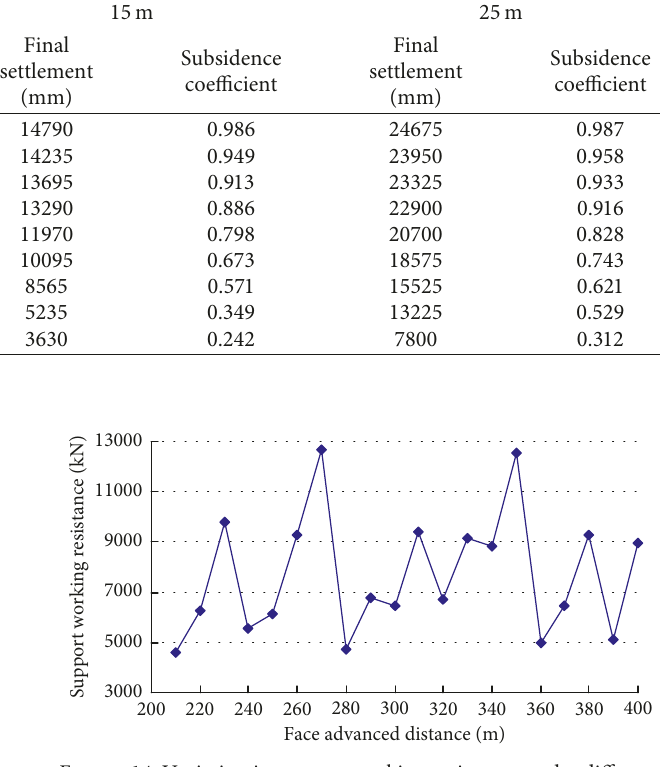
Figure 14: Variation in support working resistance under different mining distances of the working face in the 9m coal